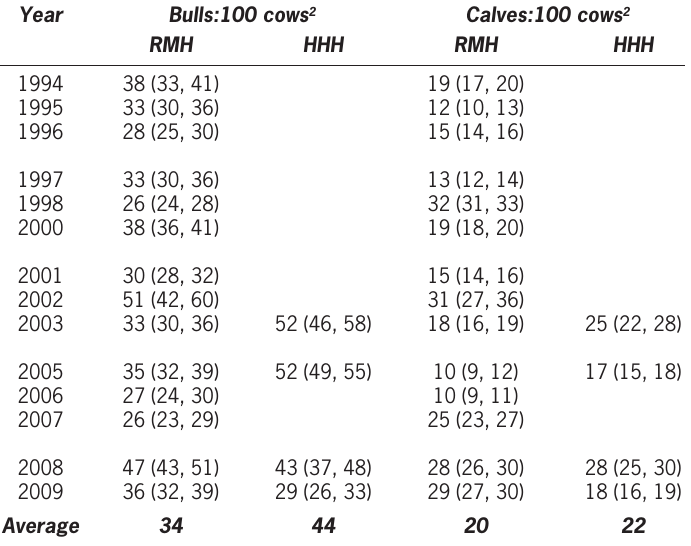
Table 3. Fall 1 herd composition for Ray Mountain and Hodzana Hills caribou.